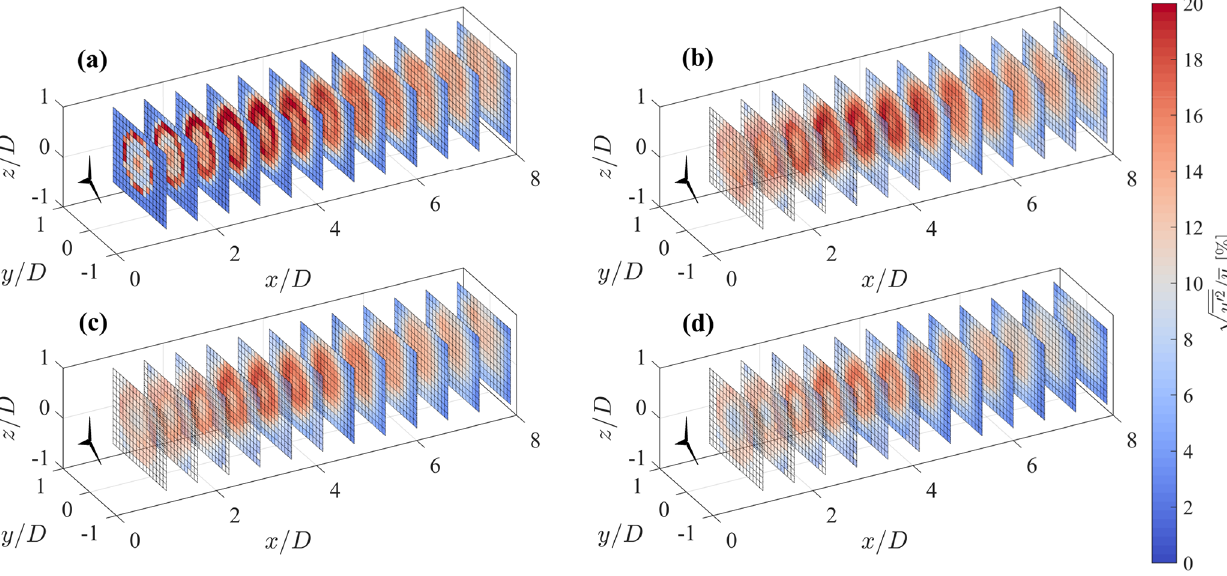
Figure 14. As in Fig. 13 but for streamwise turbulence